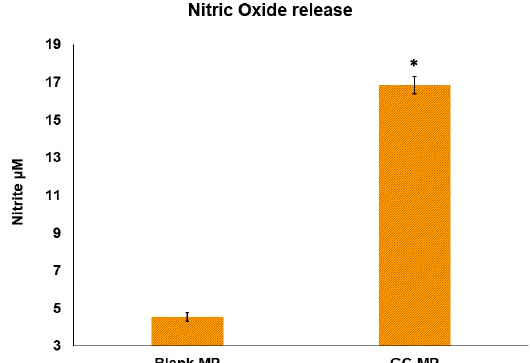
Figure 2. Nitric oxide (NO) production of murine dendritic cells DC 2.4 treated with N. gonorrhoeae microparticles. Nitric oxide release from dendritic cells was assessed in murine dendritic cells (DC 2.4) (2.5 × 10 5 ) after pulsing with gonorrhea vaccine microparticles for 16 h. Nitrite accumulation in the supernatants was determined using the Greiss reagent. Error bars represent the standard deviation from the average of two independent determinations. The data shown are representative of three independent experiments. Blank MP: empty microparticles; GC-MP: N. gonorrhoeae -loaded micropraticles. * p ≤ 0.05.